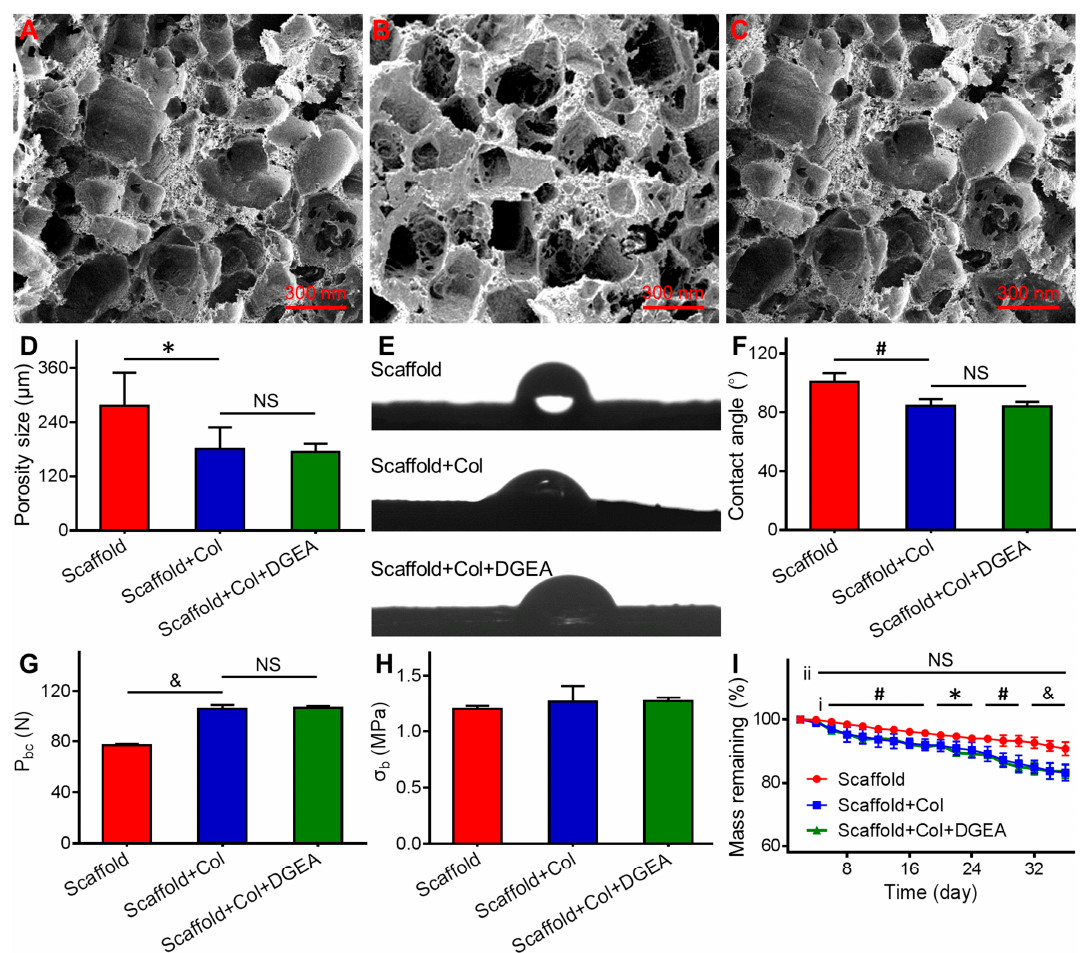
Figure 1. Morphologies, mechanical strength, and degradation. ( A – C ) Morphologies, ( D ) porosity sizes, ( E ) morphologies of contact angle measurement, and ( F ) contact angles of Scaffold, Scaffold+Col, and Scaffold+Col+DGEA, ( G ) Compressive loads, ( H ) compressive tests, and ( I ) degradation rates of Scaffold, Scaffold+Col, and Scaffold+Col+DGEA ( n = 3; * p < 0.05, # p < 0.01, & p < 0.001; i means Scaffold group vs. Scaffold+Col group; ii means Scaffold+Col group vs. Scaffold+Col+DGEA group).